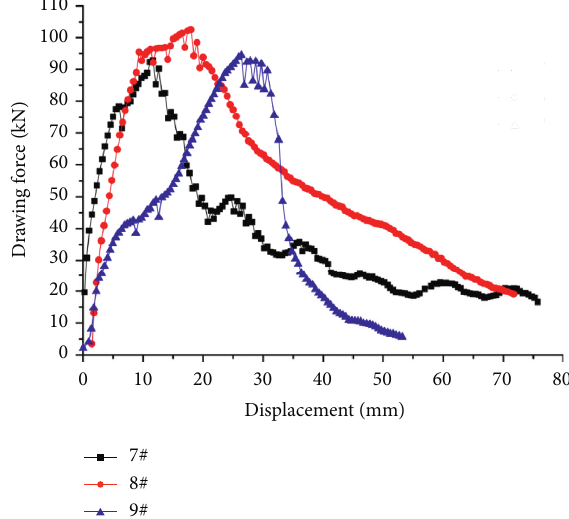
Figure 8: Drawing force of screw steel bolt (anchorage 150mm).